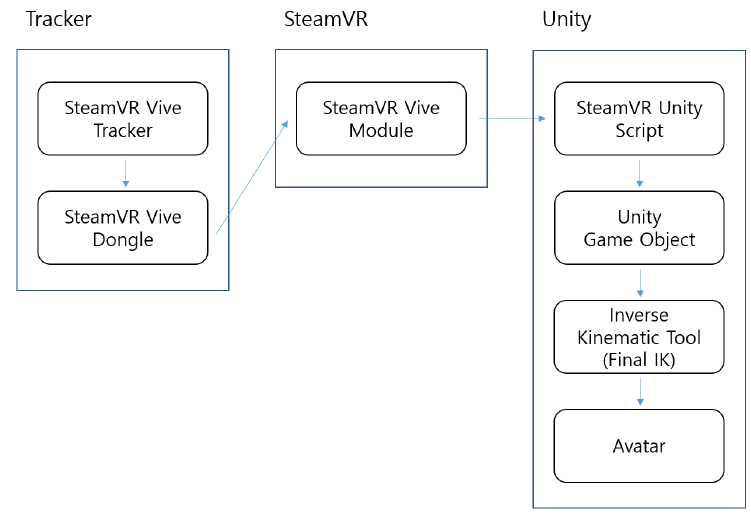
Figure 6. Motion embodiment architecture.